Question: Express in one sentence what the figure is showing.
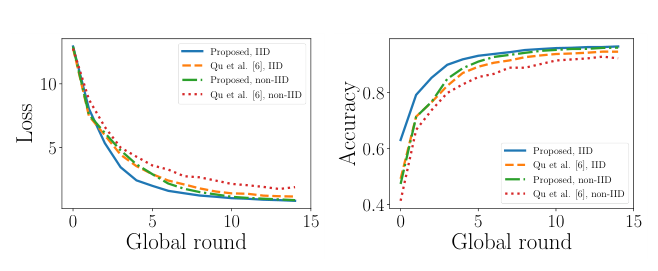
Answer: Loss and accuracy with MNIST dataset.